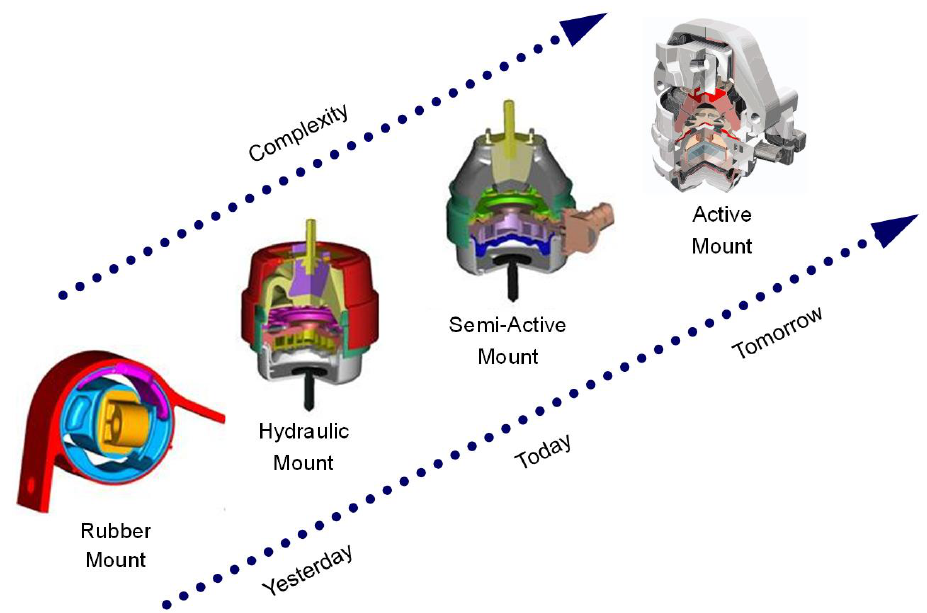
Figure 1. Schematic diagram of four types of mount.